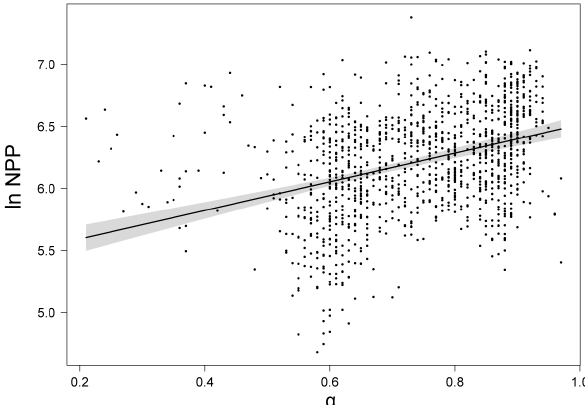
Fig. 3. Partial residual plot (Breheny and Burchett, 2013) of ob- served NPP (natural log scale) against the Cramer–Prentice α index of plant-available moisture. The partial regression line with confi- dence band as shown was based on a multiple regression of ln NPP against α , GDD 0 and mGDD 5